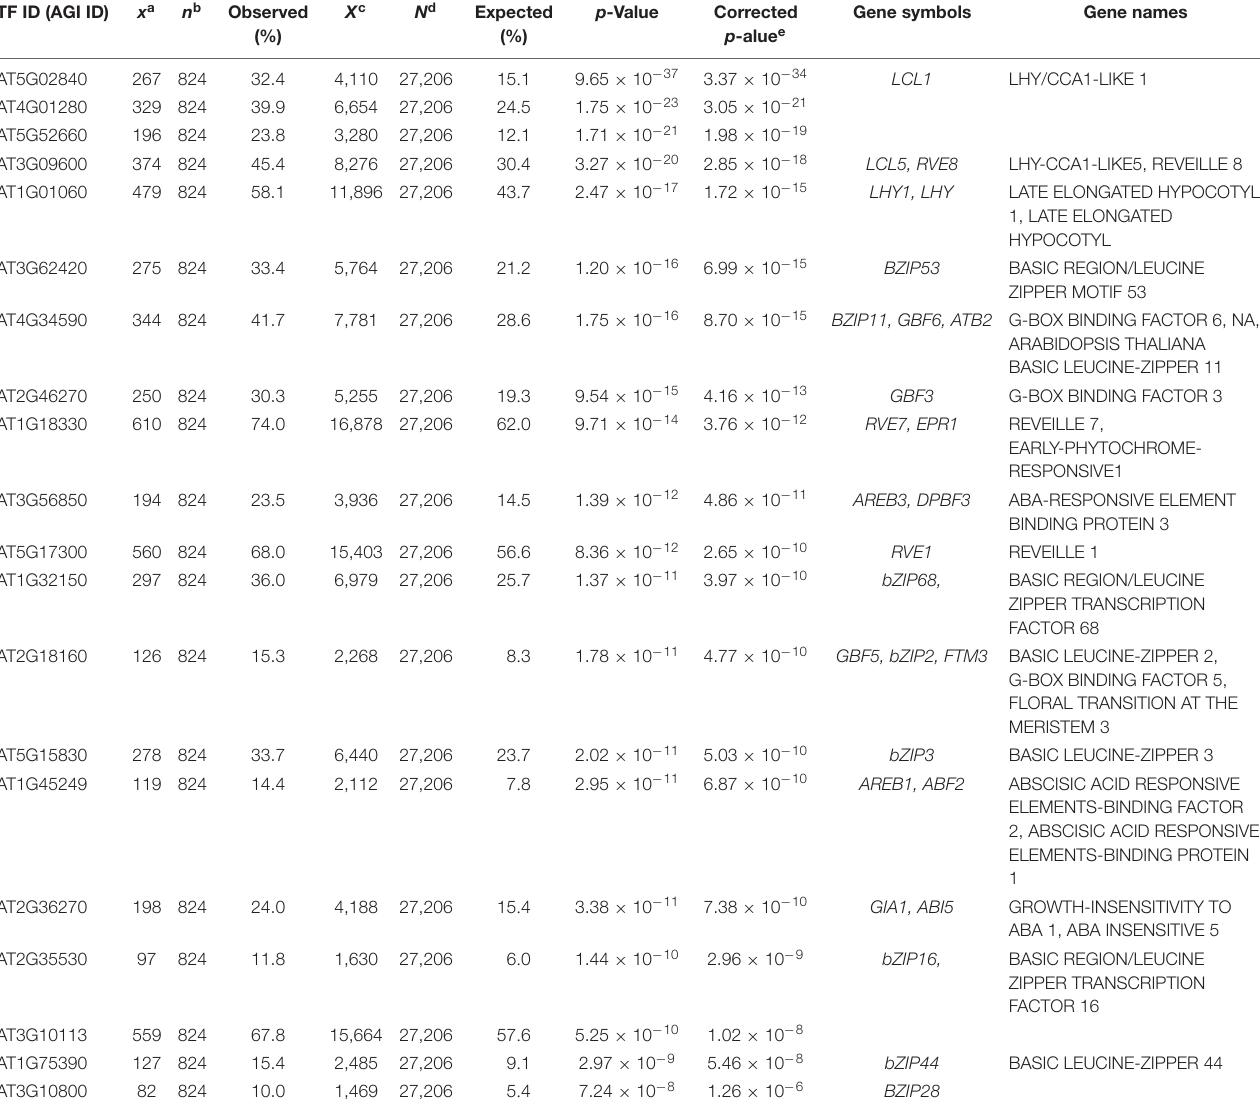
TABLE 2 | Summary statistics of enriched upstream TFs for differentially expressed genes (DEGs) in cca1lhy double mutant (Kamioka et al., 2016). TF ID (AGI